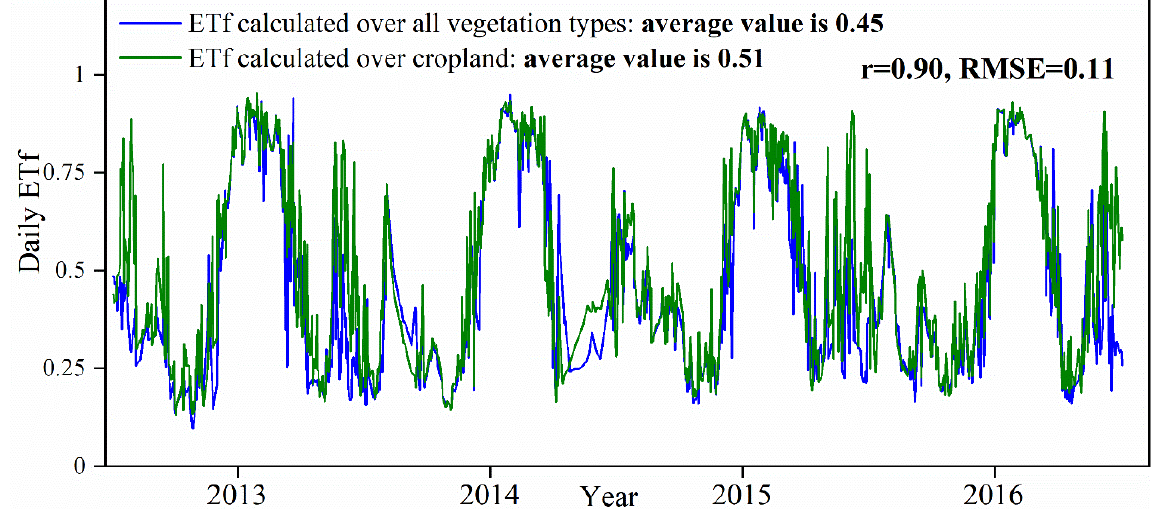
Figure 9. The regional mean daily values of ET fraction ( ET f ) calculated over croplands and all vegetation types, respec- tively.